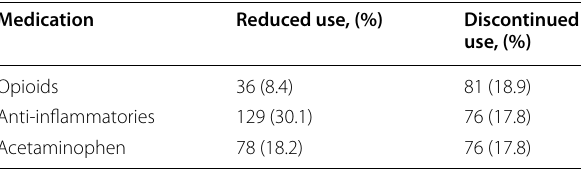
Table 6 Number of patients reporting reduced or discontinued use of opioids, anti-inflammatories, and acetaminophen since using CBD